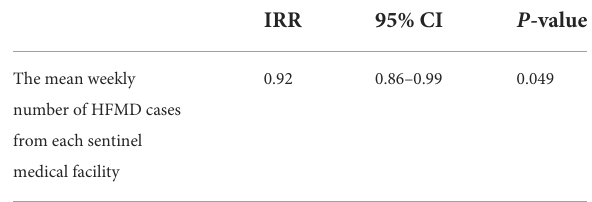
TABLE 3 Association of HFMD epidemic for the number of KD patients with resistance to the initial IVIG